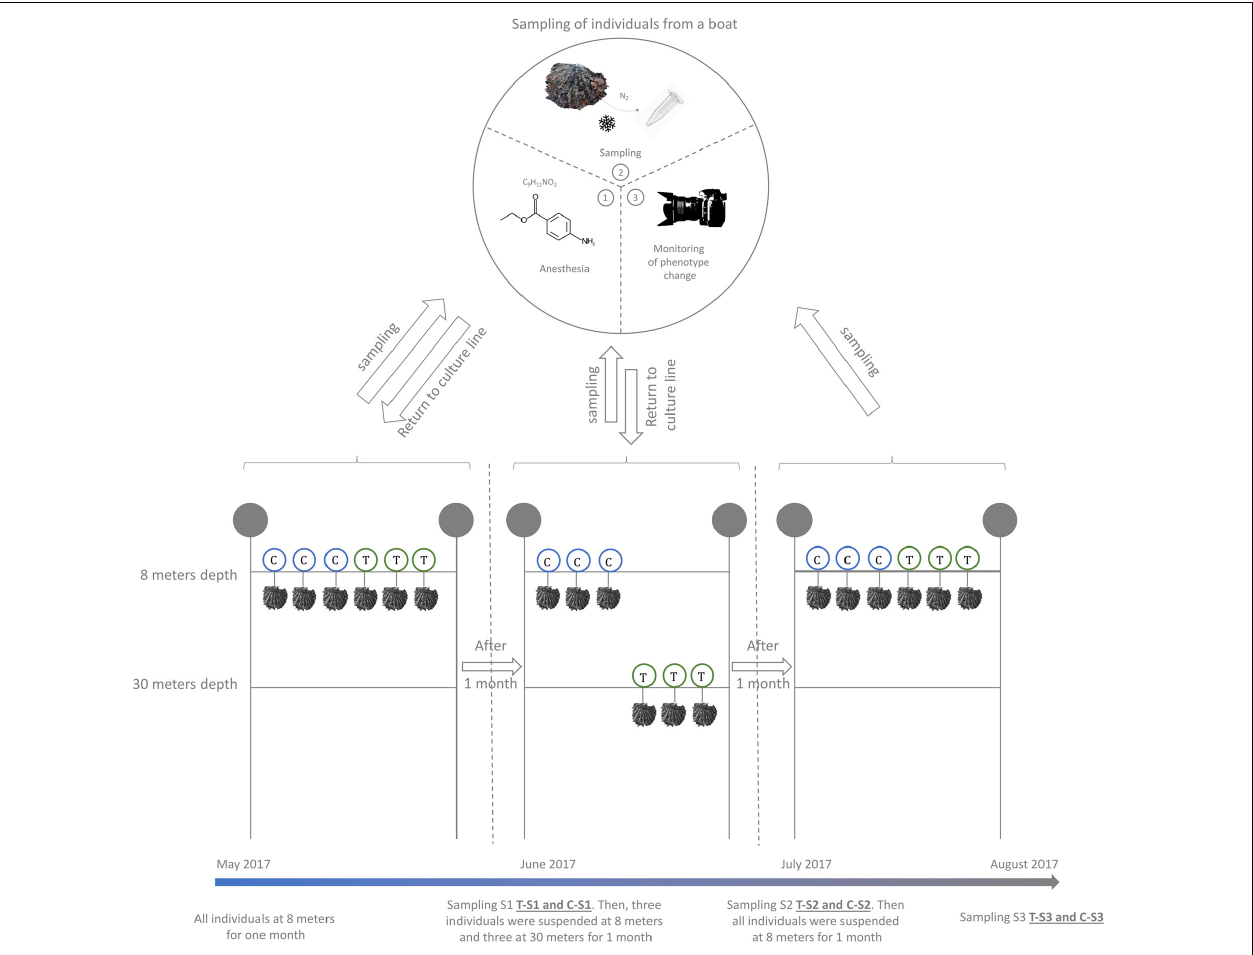
FIGURE 1 | Design of the Yo-Yo experiment. Six P. margaritifera individuals were used for this experiment. Three individuals were maintained at a depth of 8 m during the whole experiment and were used as a control (C – in blue circles). The three other individuals were subjected to depth variation treatment (T – in green circles). A non-lethal sampling of mantle tissue was made every month at the time of the depth